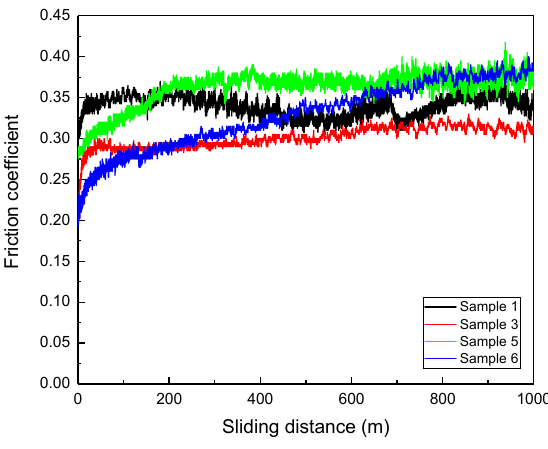
Figure 9. The COF test results.